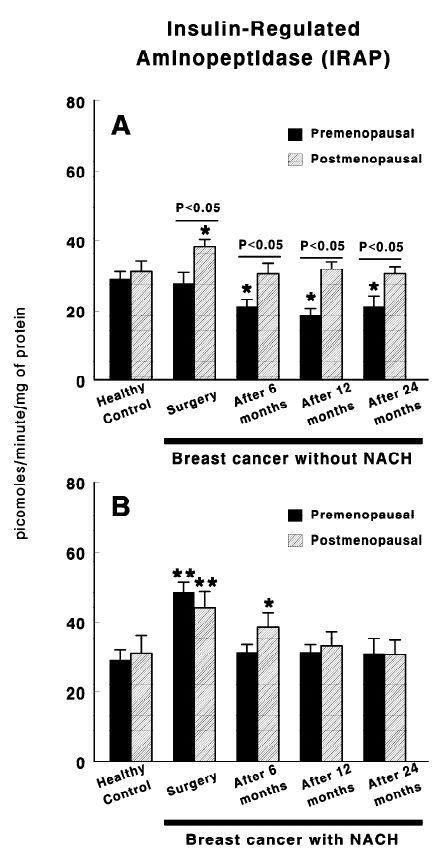
Figure 1. Specific serum insulin-regulated aminopeptidase (IRAP) activity in control, premenopausal (preMP) and postmenopausal (postMP) women and in women diagnosed with ductal infiltrating breast cancer (BC) who were untreated ( A ) or treated ( B ) with neoadjuvant chemotherapy (NACH), at the time of the surgery and at 6, 12 and 24 months after surgery. Asterisks represent significant di ff erences between breast cancer patients and healthy control women. The upper lines between bars represent the significant di ff erences between premenopausal and postmenopausal women. Results are expressed in picomoles of leucyl- β -naphthylamide hydrolyzed per min and per mg of protein (Mean ± SEM; * p < 0.05; ** p <